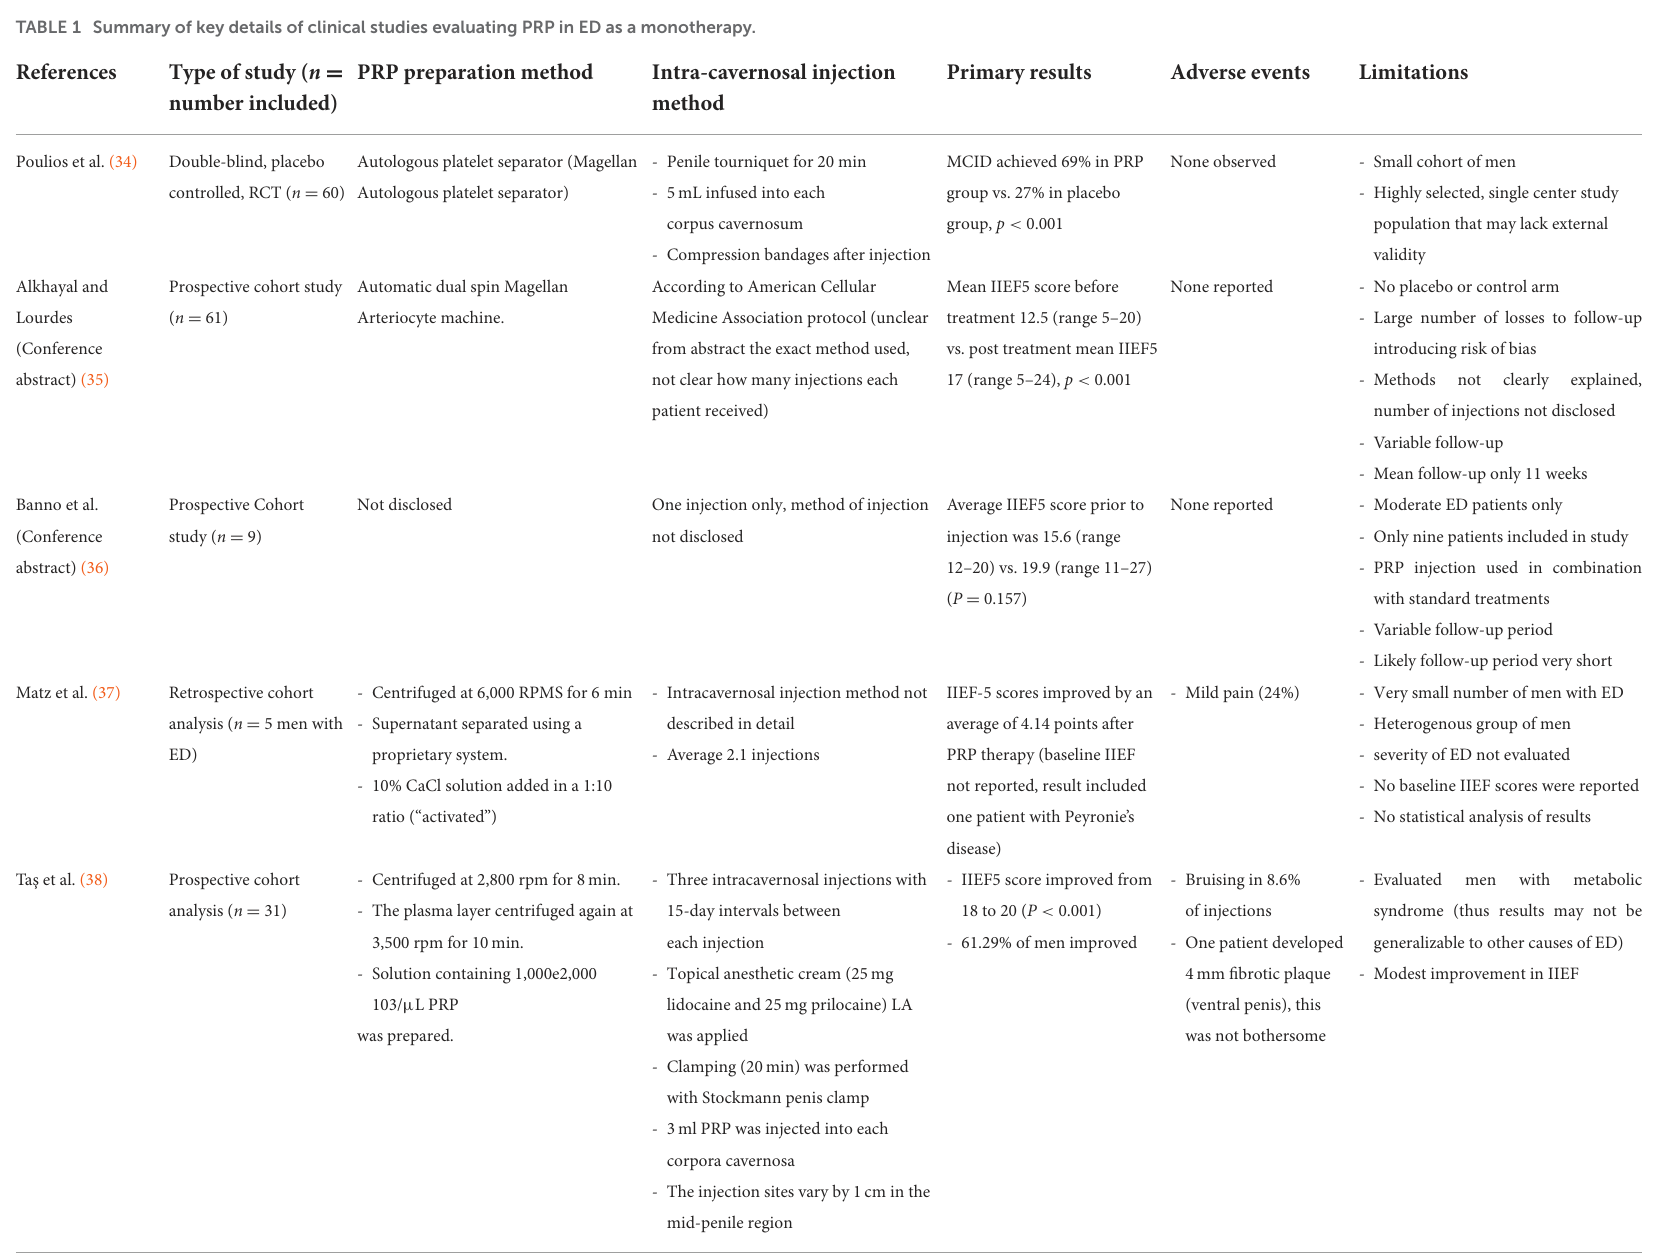
TABLE 1 Summary of key details of clinical studies evaluating PRP in ED as a